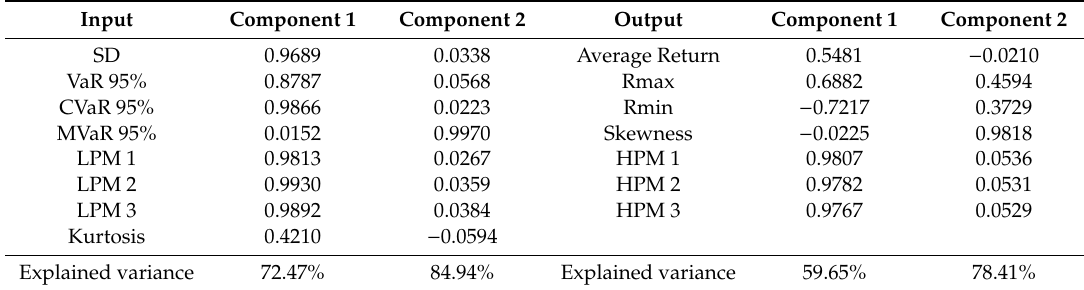
Table 3. Principal component analysis for inputs and